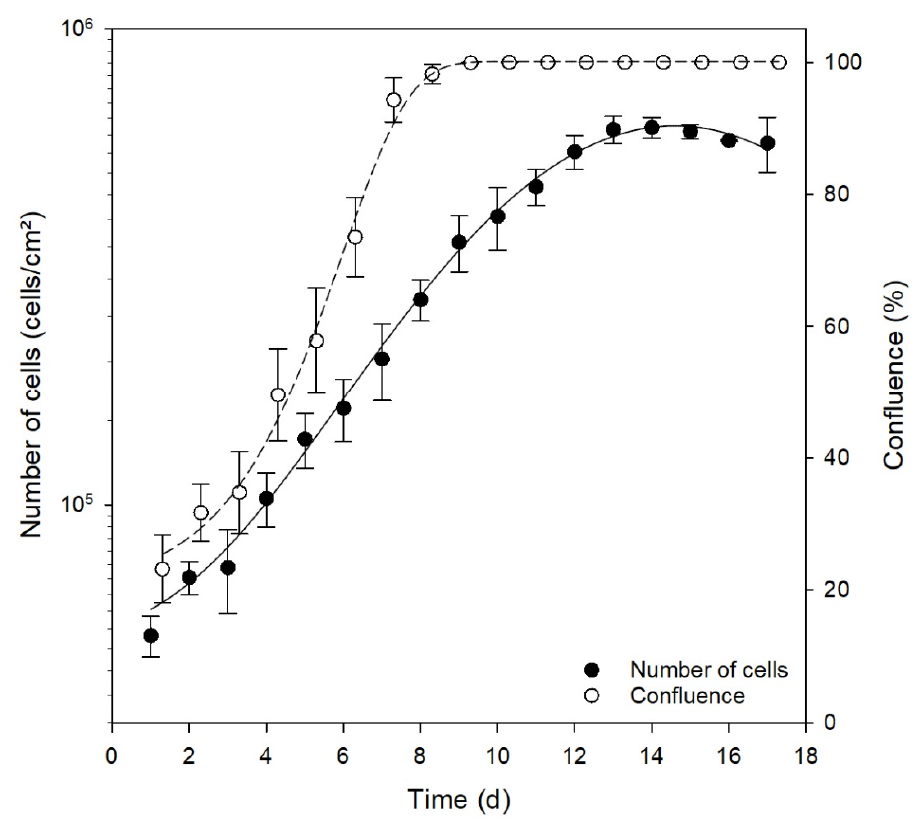
Figure 6. Proliferation of SH-SY5Y based on the cell number and confluence over a period of 17 days. The number of cells and confluence were determined via live-cell imaging within the incubator. (Regression coefficient for total cell number: r 2 = 0.9956; for confluence: r 2 = 0.9982.)